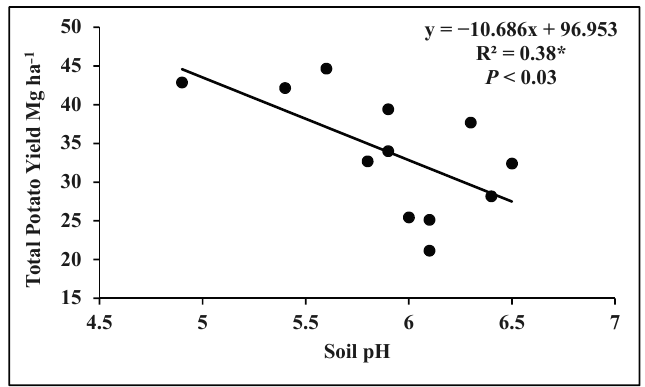
Figure 2. Correlation between the highest total potato tuber yield value (Mg ha − 1 ) at each site and soil pH (pre-planted soil samples).* Significantly different at P < 0.05 .